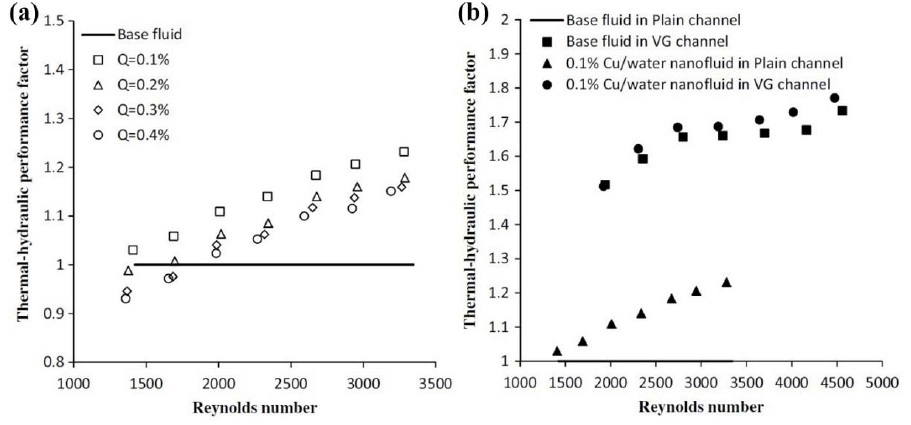
Figure 21. Variations of the thermal ‐ hydraulic performance versus Re number for: ( a ) different nanofluids flow inside plain channel, and ( b ) different heat transfer enhancement methods. Reproduced with permission from [207]. Springer Nature, 2015.